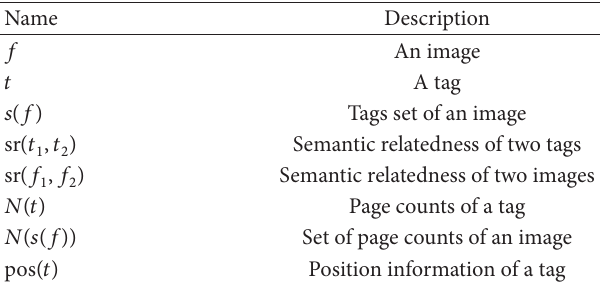
Table 1: The variables and parameters used in the proposed com- putation